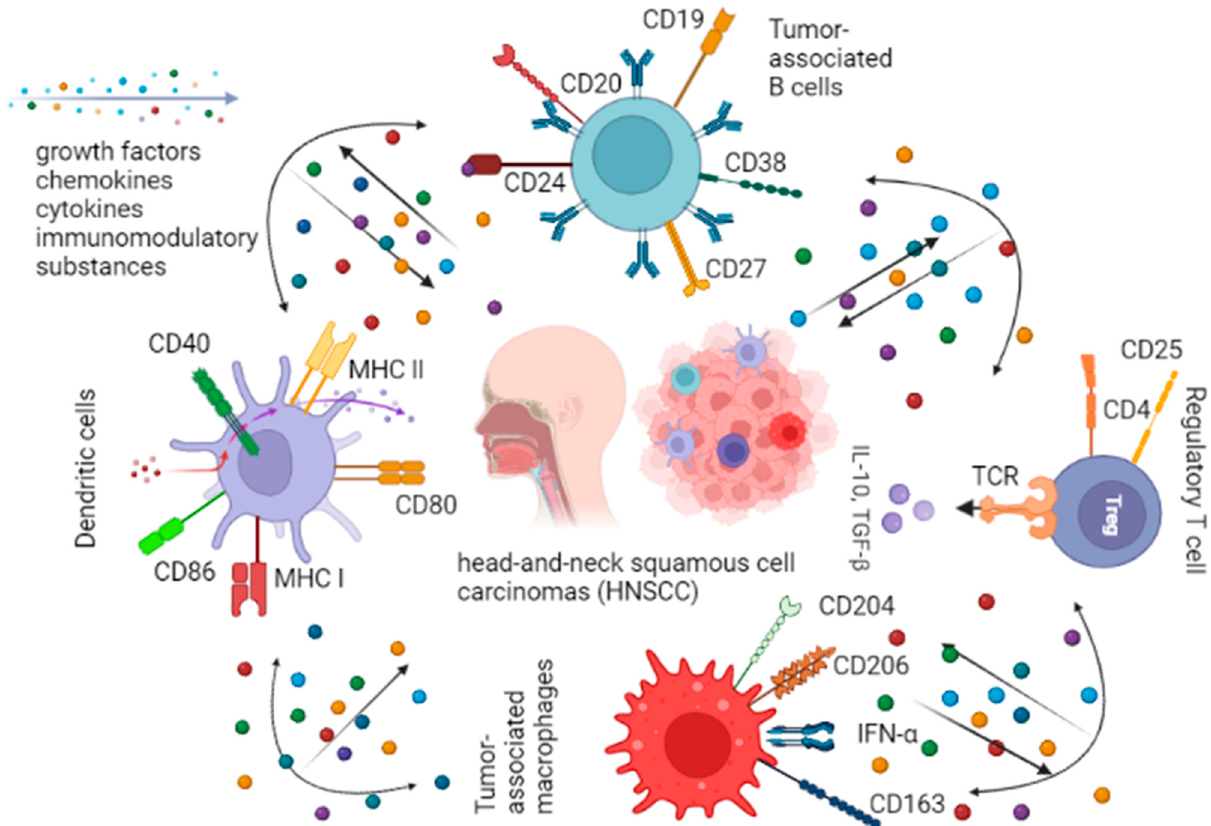
Figure 1. Immune cells in head-and-neck tumor microenvironments .